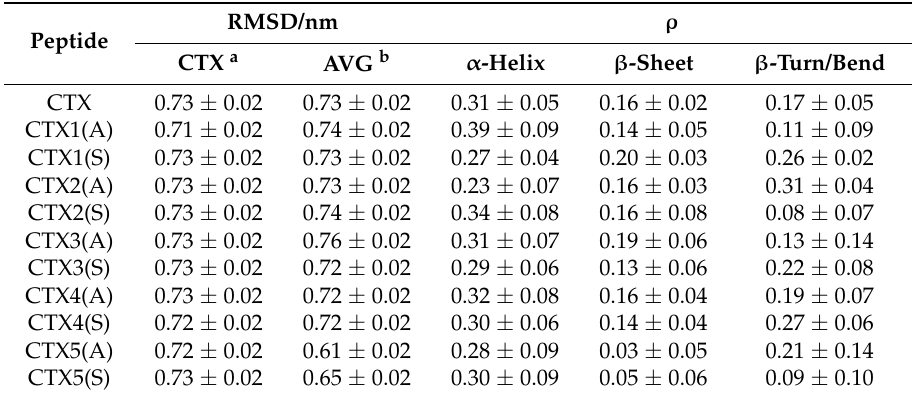
Table 2. Calculated (mean ± SD) C α -trace RMSDs between the peptide and the average conformation of CTX, between the Abu- or Ser-substituted analog and the average conformation of itself, and the fraction ( ρ ) of sampled DSSP secondary structure.